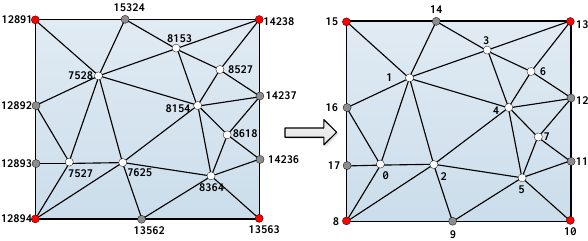
Figure 3. Local index assignment for each vertex in a